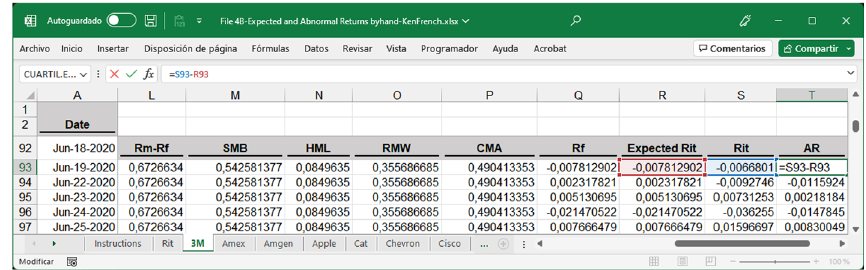
Fig. 8 Partial 3 M spreadsheet structure to calculate expected and abnormal returns. Source : Created by